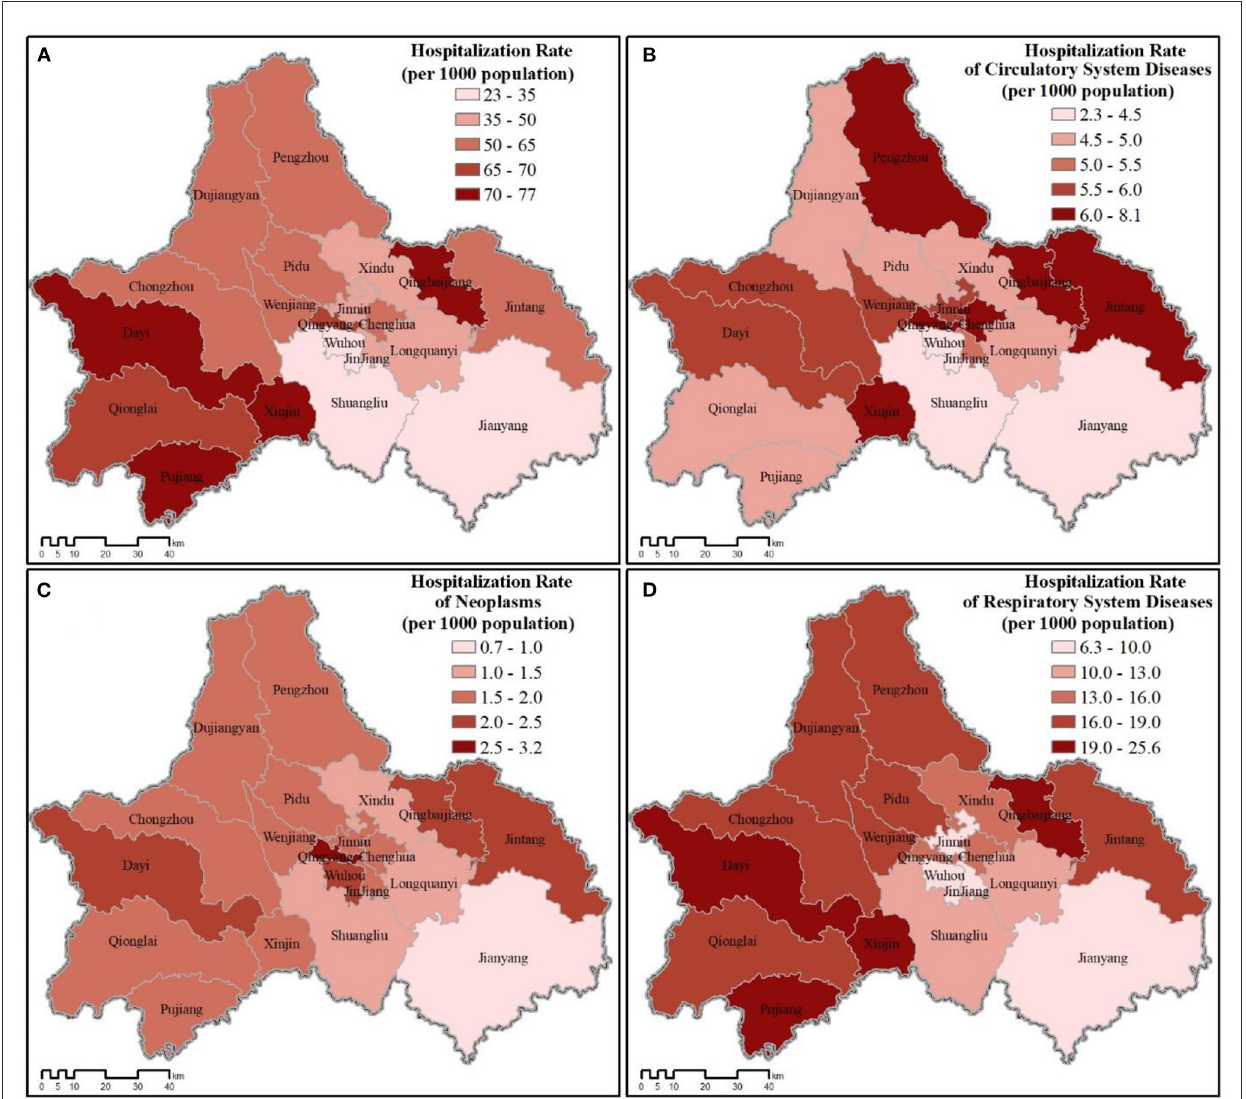
FIGURE4 Hospitalization rate for all county-level jurisdictions across Chengdu (2016). (A) Total hospitalization rate. (B–D) Hospitalization rate for each disease